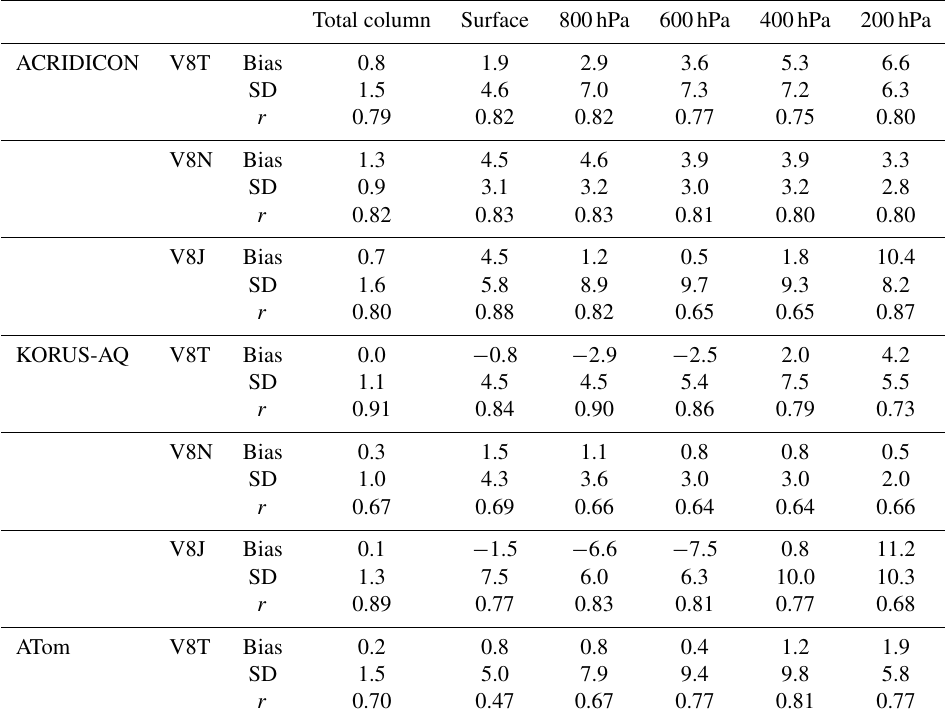
Table 5. Summarized validation results for V8 products based on in situ data from ACRIDICON-CHUVA, KORUS-AQ, and ATom field campaigns. See caption to Table